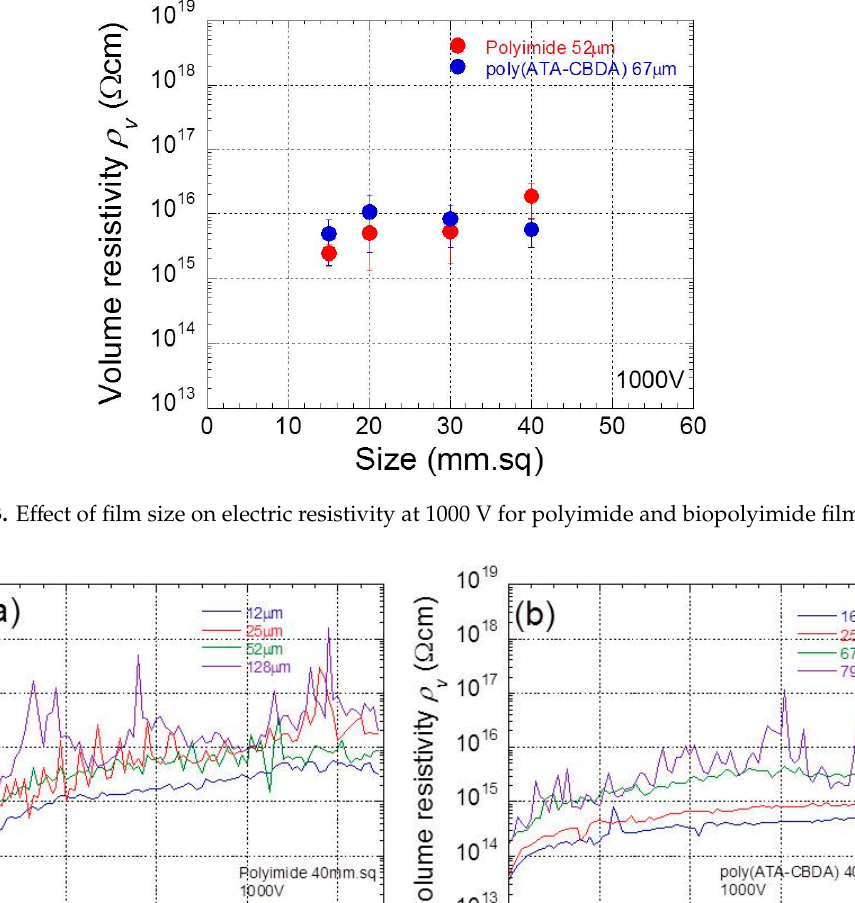
Polymers 2018 , 10 , x FOR PEER REVIEW Figure 3. Effect of film size on electric resistivity at 1000 V for polyimide and biopolyimide films.